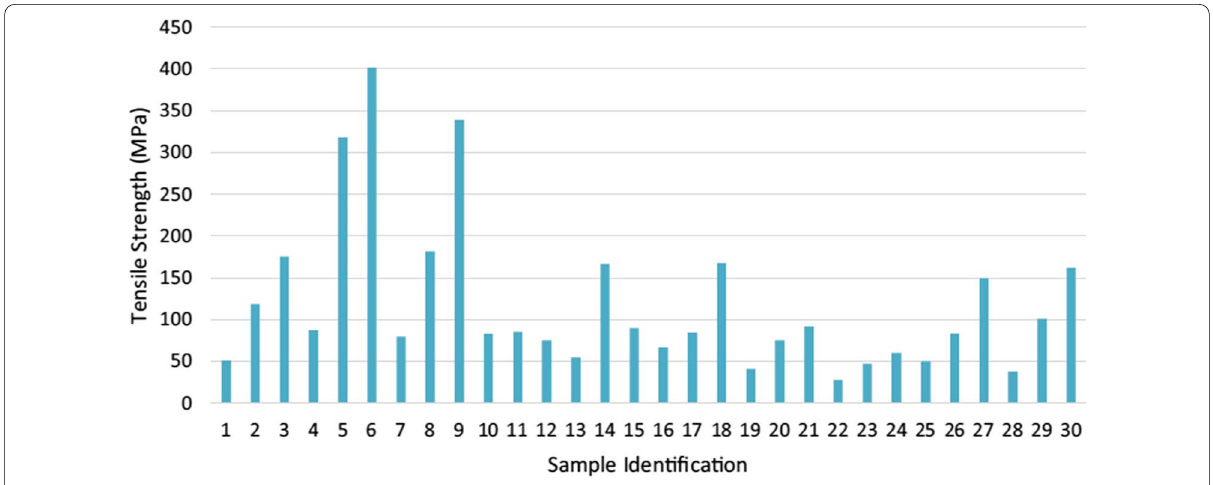
Fig. 2 Tensile strengths response of plantain fibre polystyrene composites (Alavudeen et al.